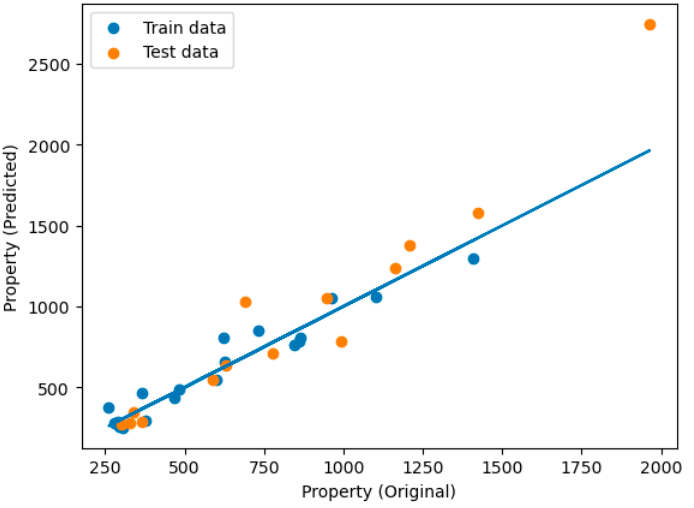
Figure 5. Confusion matrix of the training and test groups, regarding the samples’ membership to one of three portions.